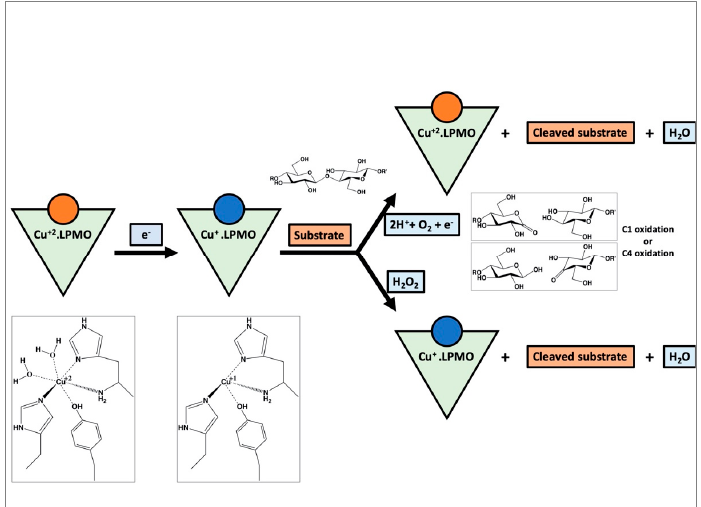
Figure 2. A simplified diagrammatic representation of the reaction mechanism of LPMOs exemplified by cellulose degradation. The reaction proceeds by reduction of the Cu from Cu(II) to Cu(I), substrate binding and the subsequent cleavage of the substrate by the oxygen species. Depending on the source of the oxygen species being either molecular oxygen or hydrogen peroxide, the reaction proceeds differently, yielding the cleaved substrate by C1 or C4 oxidation or both.